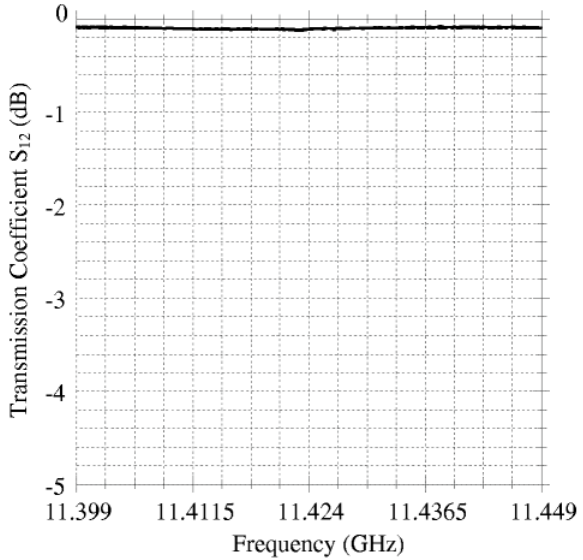
FIG. 18. The transmission through two TE 01 mode transducers connected from their circular ports using the arc tapers.